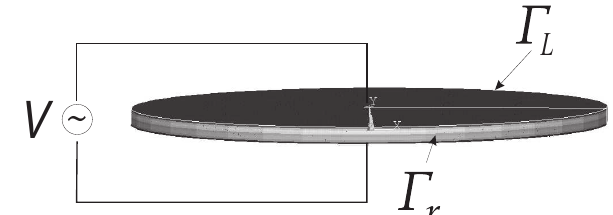
Figure 1. Two-electrode configuration on a circular disk (Lahmer, 2008).